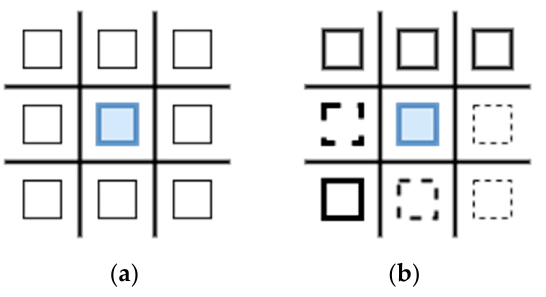
Figure 2. ( a ) Normal neighborhood structure. ( b ) Neighborhood of agents with varying degrees of inertia.